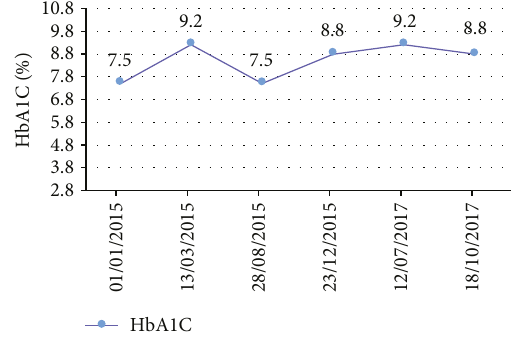
Figure 15: HbA1C follow-up from 2015 to October